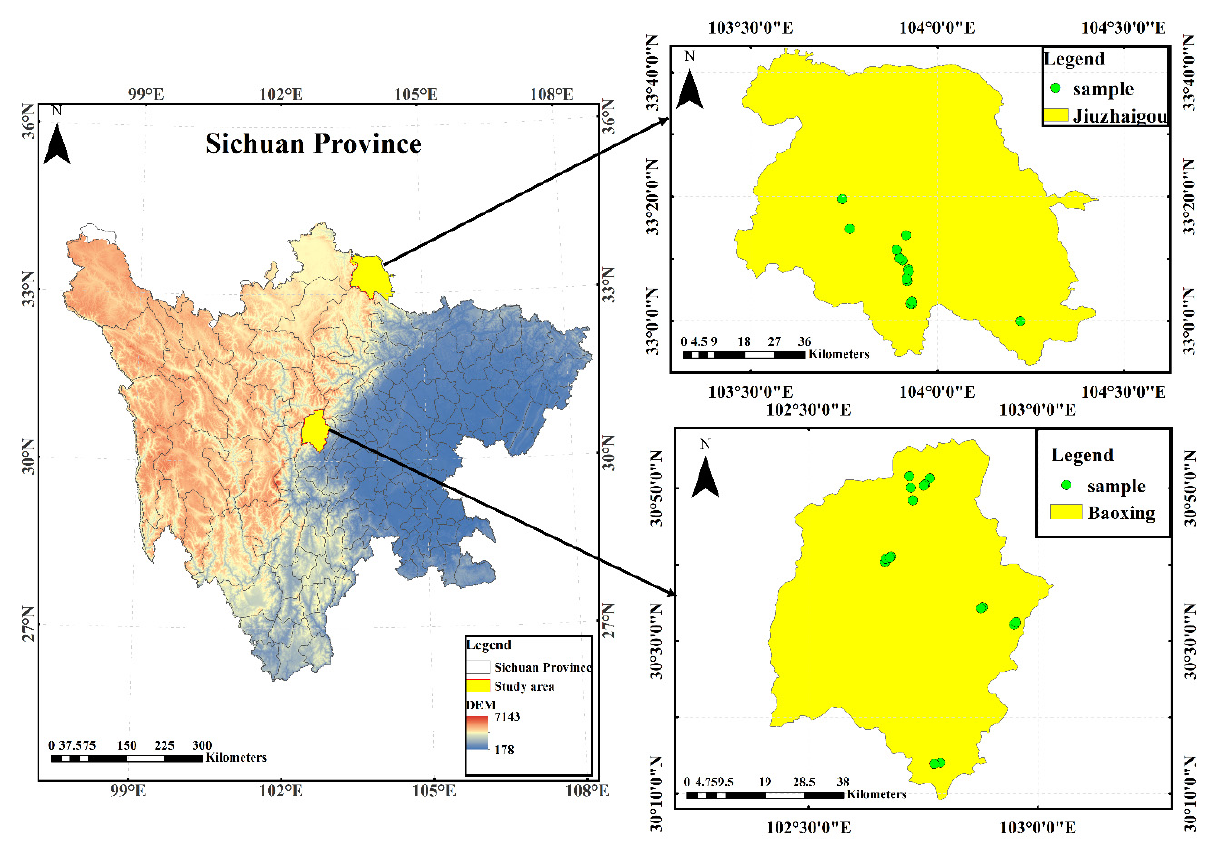
Figure 1. Location of the study region.